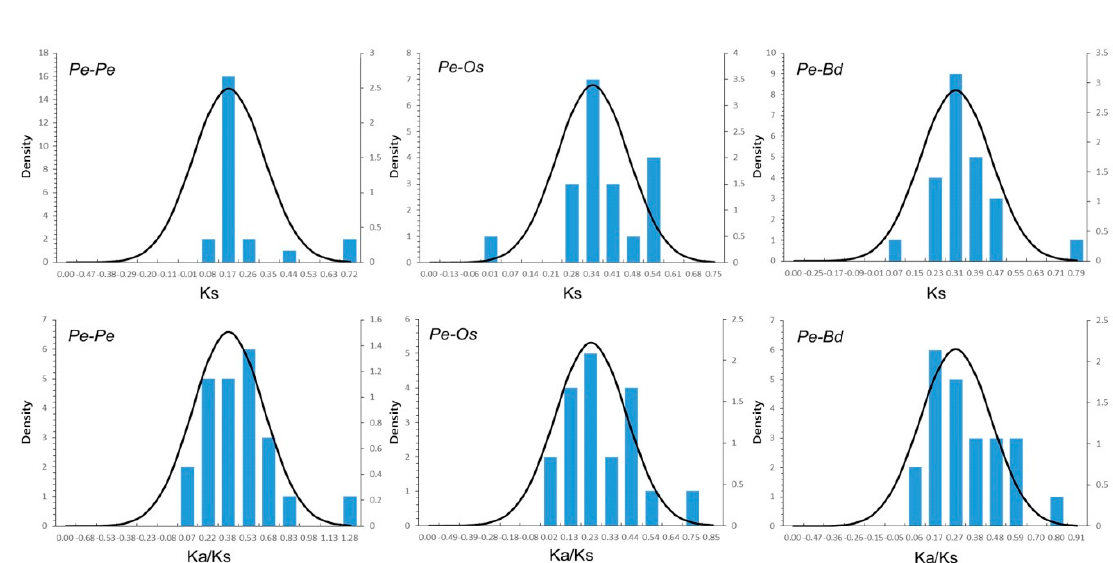
Figure 6. Ks and Ka / Ks value distributions of the PeUBP genes in the genomes of moso bamboo, rice, and Brachypodium distachyon , viewed through the frequency distribution of relative Ks and Ka / Ks modes. Distributions of Ks and Ka / Ks values were obtained from paralogous gene pairs in the moso bamboo genome, orthologous gene pairs between moso bamboo and rice, and orthologous gene-pairs between moso bamboo and B. distachyon . Table 2. Paralogous (Pe-Pe) and orthologous (Pe-Os and Pe-Bd) gene pairs.